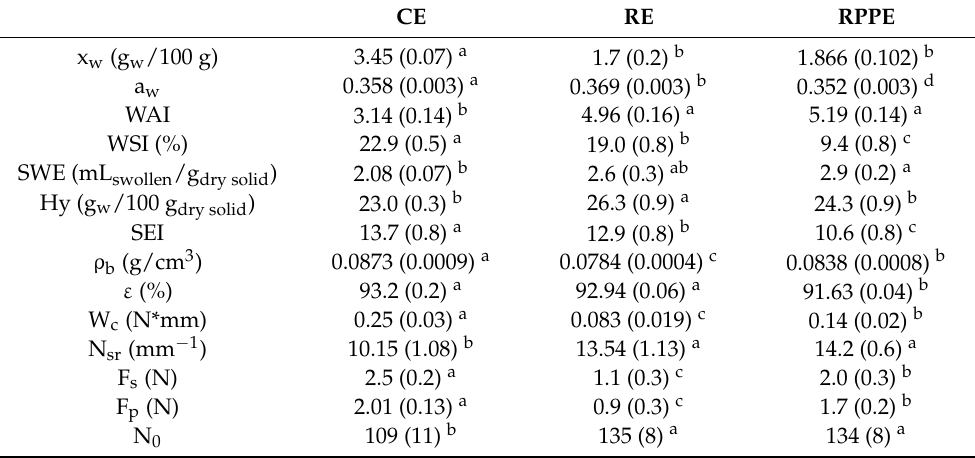
Table 2. Mean values (and standard deviations) of extrudate